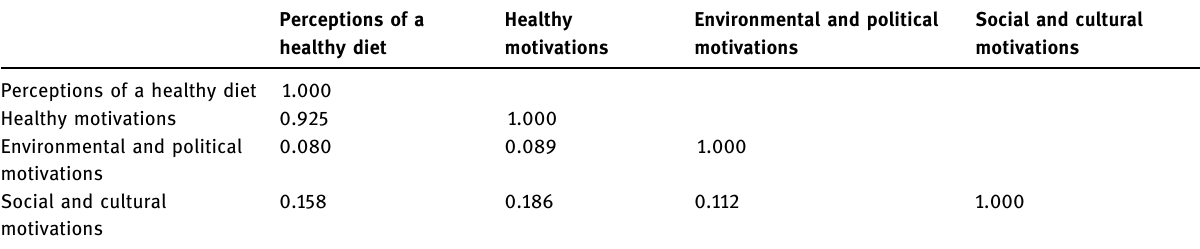
Table 5: Correlations between the variable perception of healthy eating and three food motivations in the research model Perceptions of a healthy diet